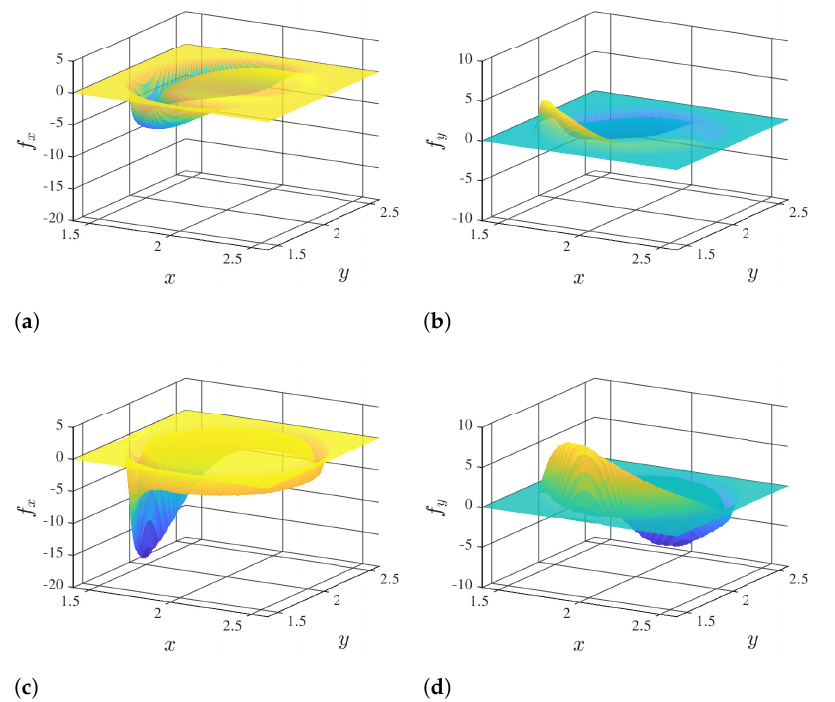
Figure 10. Components of volume forces obtained by using IB-PINN and mesh-based IB method. ( a ) x-component (IB-PINN); ( b ) y-component (IB-PINN); ( c ) x-component (IB); ( d ) y-component